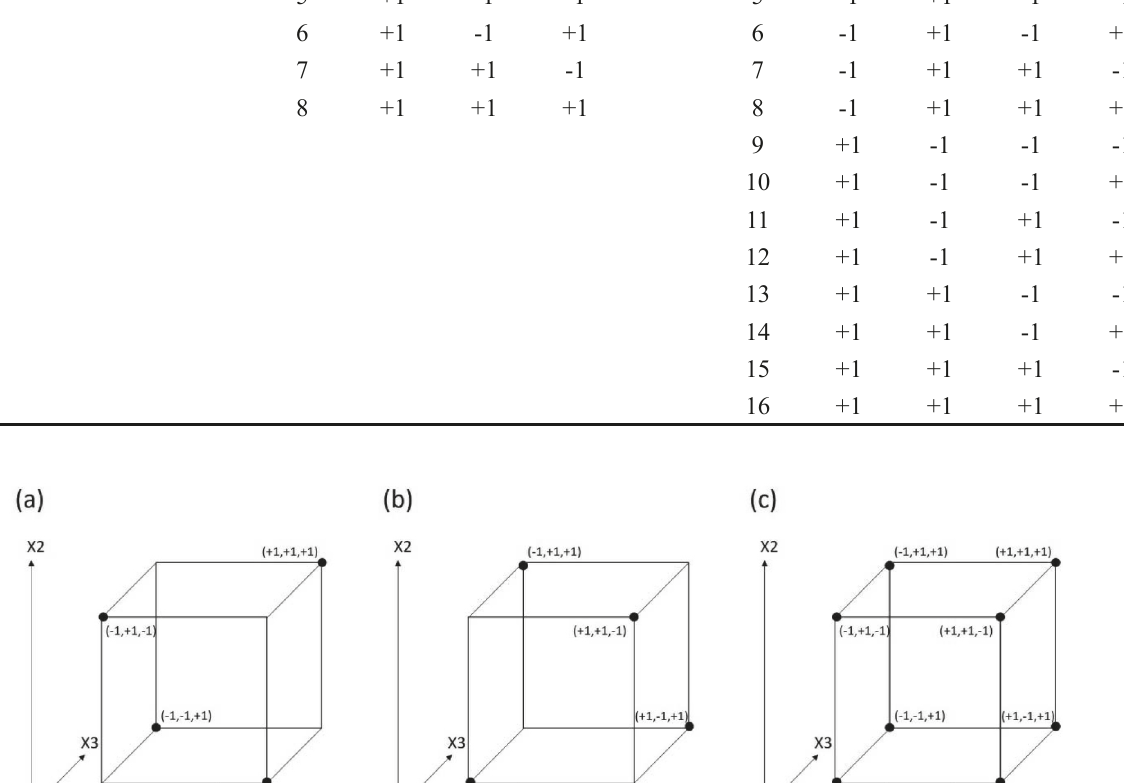
FIGURE 2 – Illustration of a half-fractionate two-level factorial design (2 3-1 level full factorial design (2 3 ) matrix (c) for three input